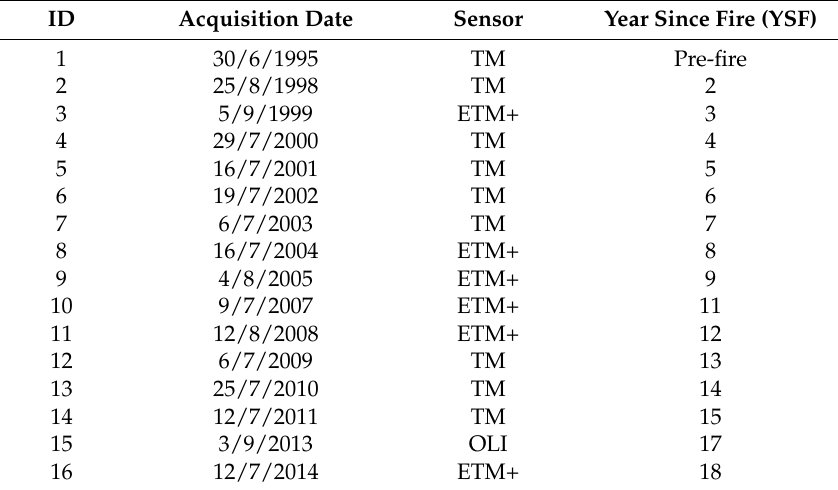
Table 1. Time-series Landsat images for assessing drivers of post-fire Larch forest patterns in the 1996 burned area in northern Mongolia. No images in 1997, 2006, and 2012 were found for the study area. ID Acquisition Date Sensor Year Since Fire (YSF) 30/6/1995 TM